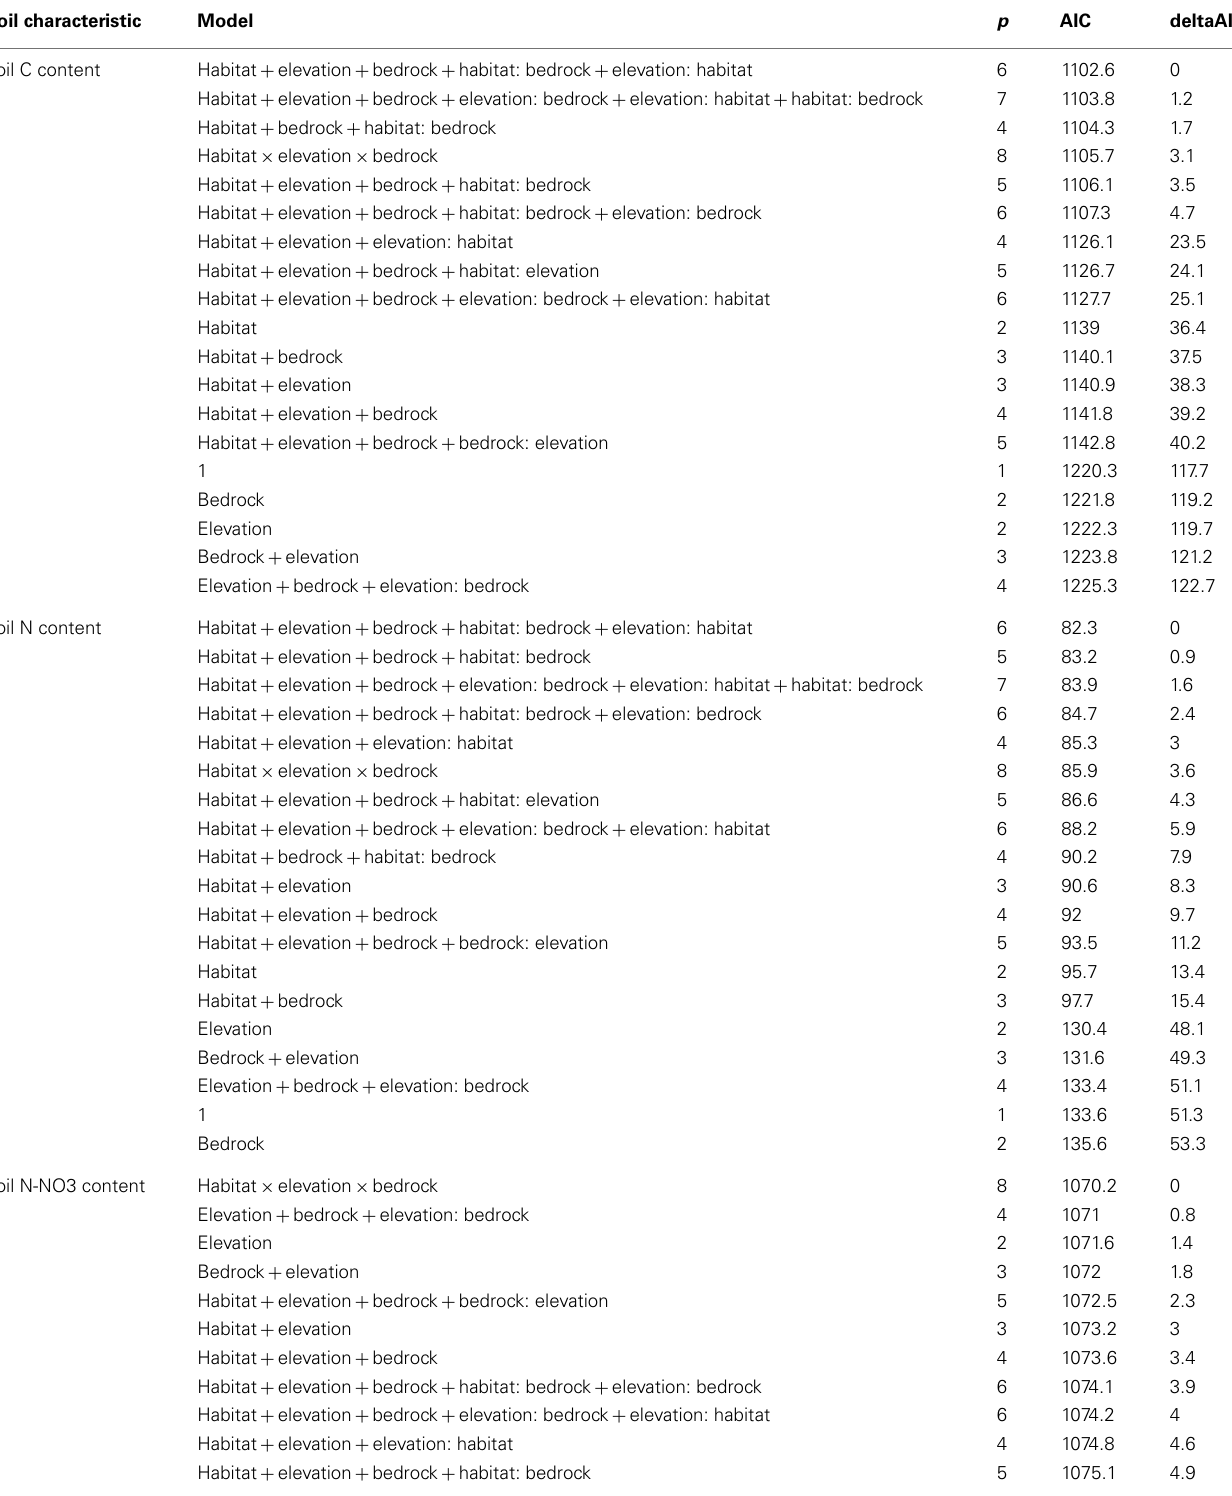
TableA1 | Model selection of fixed effects and interactions explaining the variation in soil